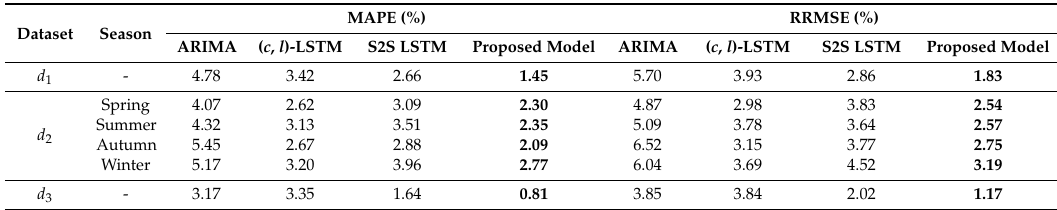
Table 5. Errors for d 1 , d 2 and d 3 .